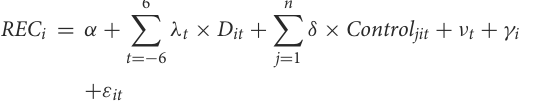
and the absolute values show a gradual increasing trend. The solid dots indicate the estimated coefficients λ t of equation (3), and the error bar are upper and lower 95% confidence